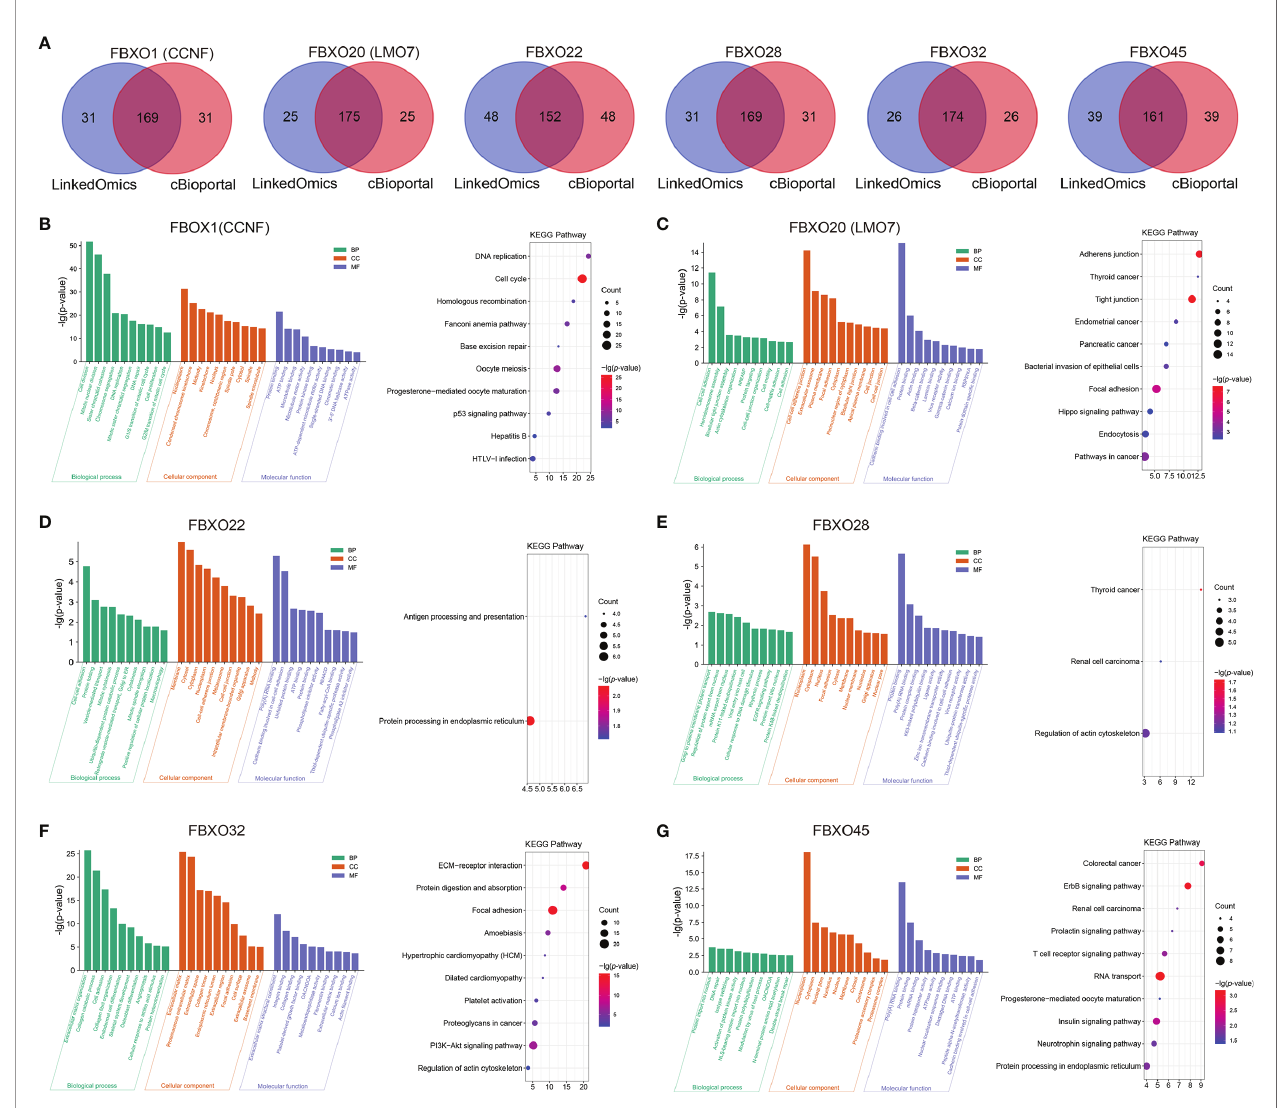
FIGURE 8 | Comprehensive bioinformatics analysis of six-FBXOs and individual co-expressed genes in pancreatic ductal adenocarcinoma. (A) Intersection of genes positively co-expressed in the top 200 of the LinkedOmics and the cBioPortal database (Spearman correlation). (B – G) The Gene Ontology enrichment analysis and Kyoto Encyclopedia of Genes and Genomes pathway prediction of six-FBXOs were performed. BP, biological processes; CC, cellular components; MF, molecular